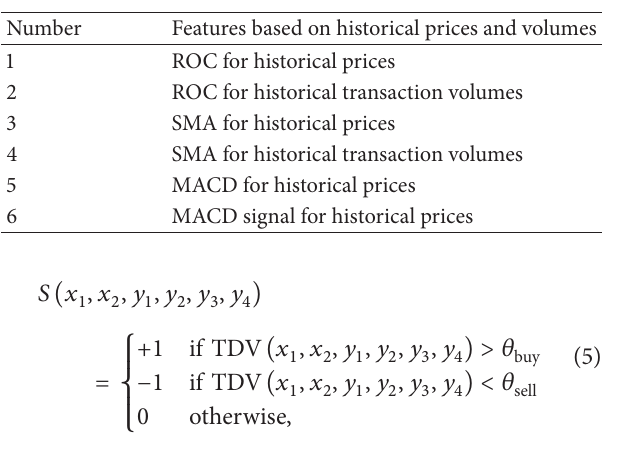
Table 2: List of features from historical traded prices and